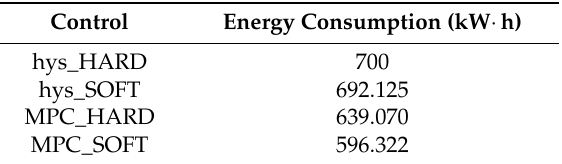
Table 3. Energy consumption in February.